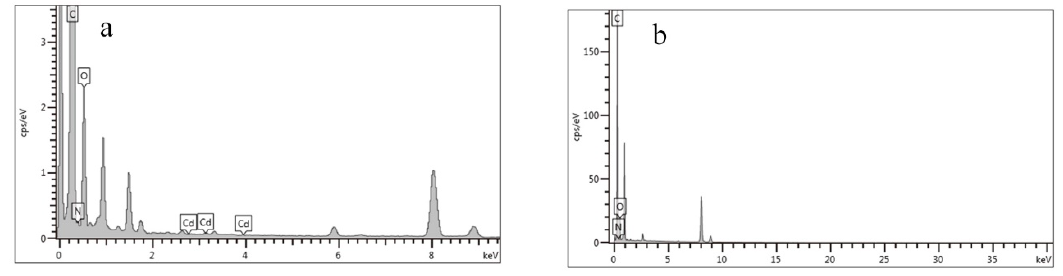
Figure 5. ( a ) EDS spectrum of Cd(II)-IIP / ERGO / GCE, ( b ) EDS spectrum of IIP / ERGO / GCE.